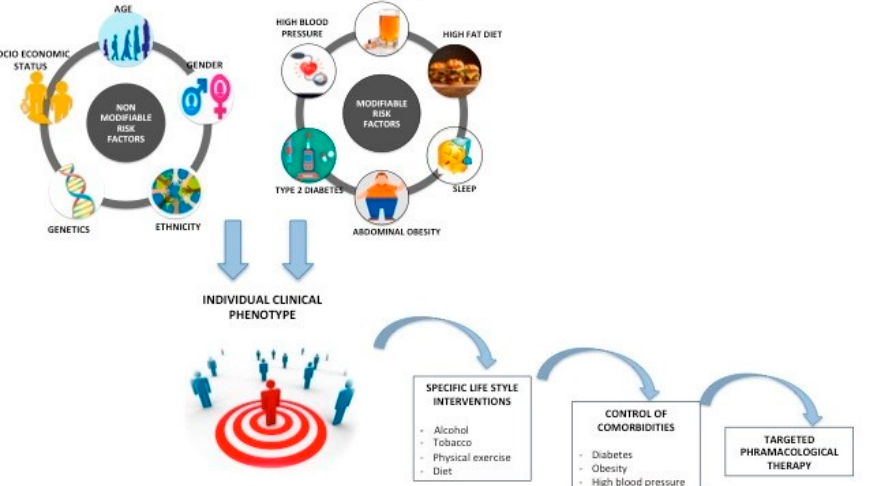
Figure 1. The severity of the liver damage in non-alcoholic fatty liver disease (NAFLD) is determined by the interaction of multiple risk factors combined in a well-determined clinical phenotype. Some of these factors (i.e., age, gender, genetics, etc.) cannot be modified, while others (obesity, type 2 diabetes, high blood pressure, sleep apnea) can be modified through specific interventions (general lifestyle measures or targeted control of comorbidities). Because of a unique clin- ical phenotype of each patient, NAFLD therapeutic interventions should be tailored on a clinical-based personalized ap- proach for the selection of the best non-pharmacological approach or drug candidates to target a specific physiopatho- genic